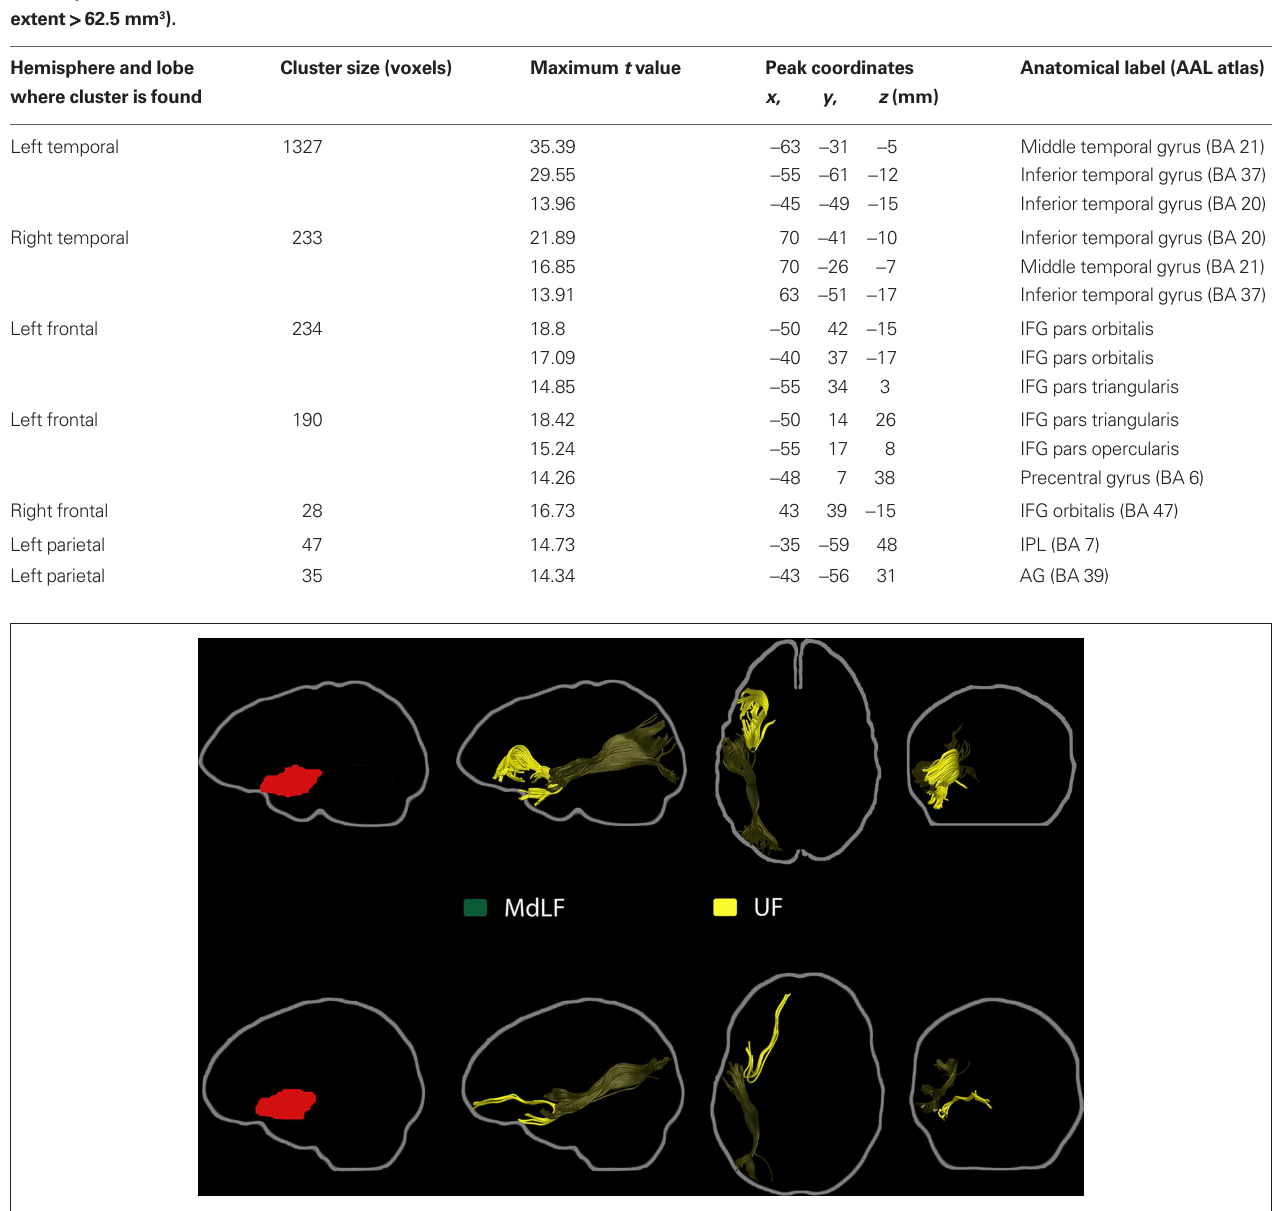
Figure 6 | Pathways associated with the anterior STg/BA22 region of interest (left, red). Streamline tractography results from two subjects are presented as exemplars. The middle longitudinal fasciculus and the uncinate fasciculus were found to be associated with this ROI.